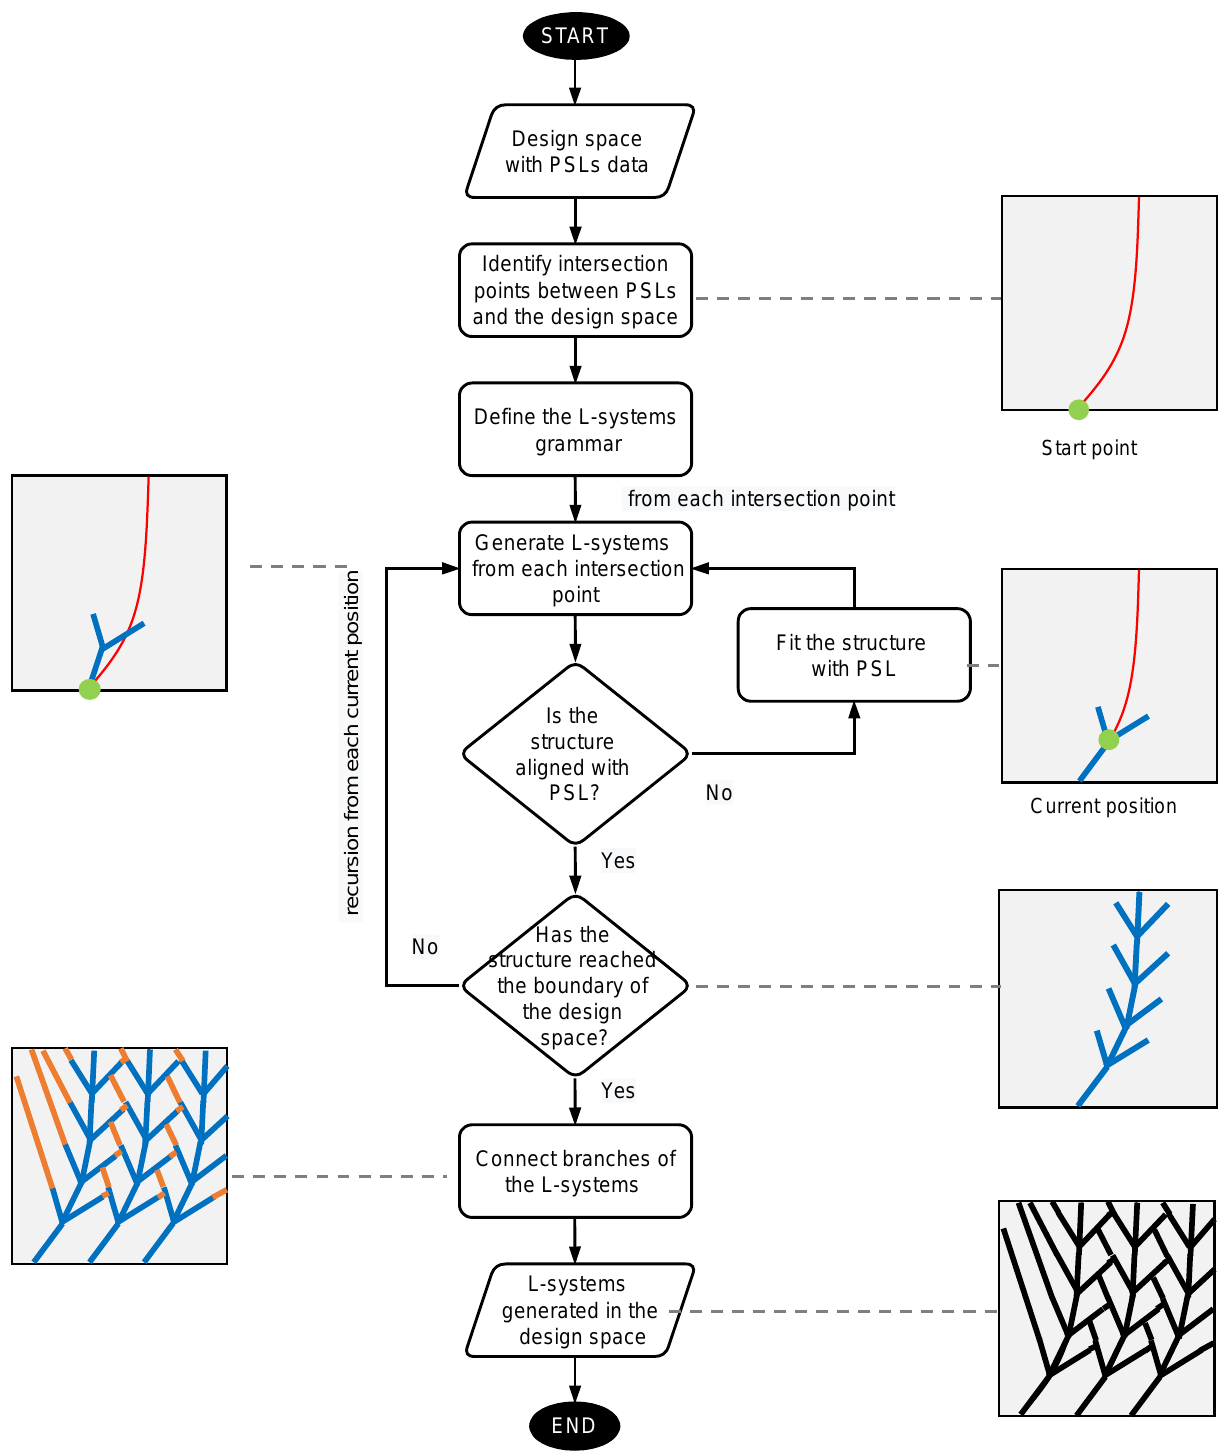
Figure 5. Flowchart describing the L-systems’ generation along PSLs’ directions within a 2D design space.